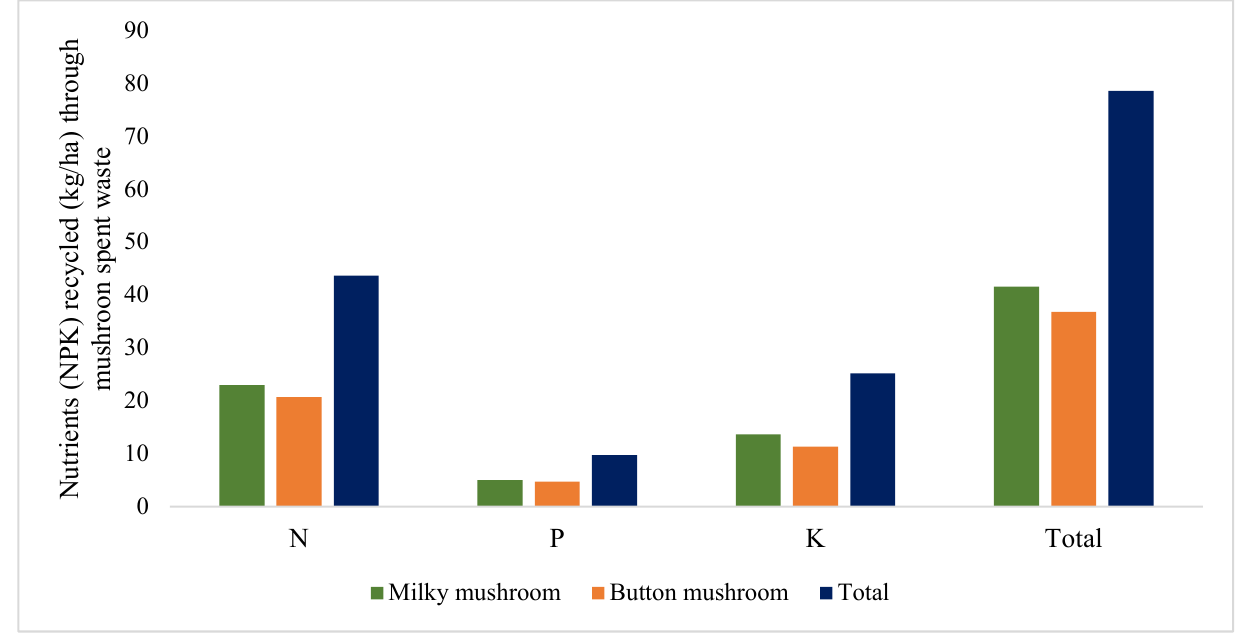
Figure 2. Nutrients recycled (NPK, kg/ha) in two years (2020 –2021 and 2021–2022) from mushroom- spent wastes.